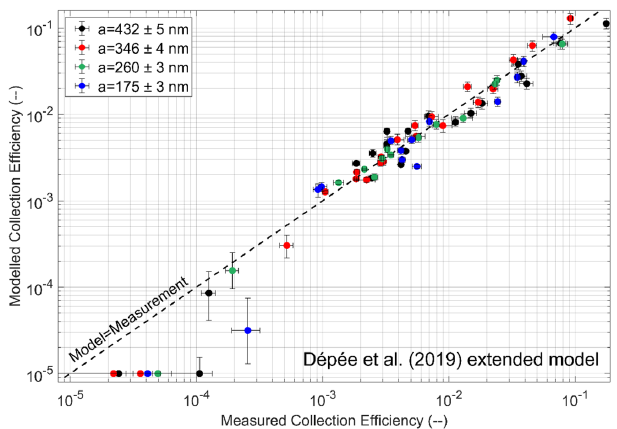
Figure 10. Modelled CE from the extended model of Dépée et al. (2019) as a function of the measured CE. The droplet radius is 48 . 5 ± 1 . 1µm. The colour code referrers to the AP radius. The experimental conditions are summarised in Table